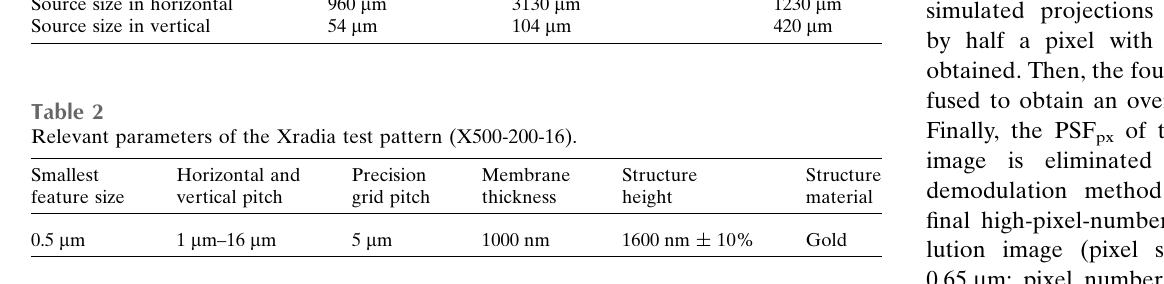
Table 1 lists the design parameters of the SSRF BL13W1 beamline. The Xradia test pattern (X500-200-16, Xradia Inc., now Zeiss) has a line-width between 0.5 m m and 8 m m, i.e. a